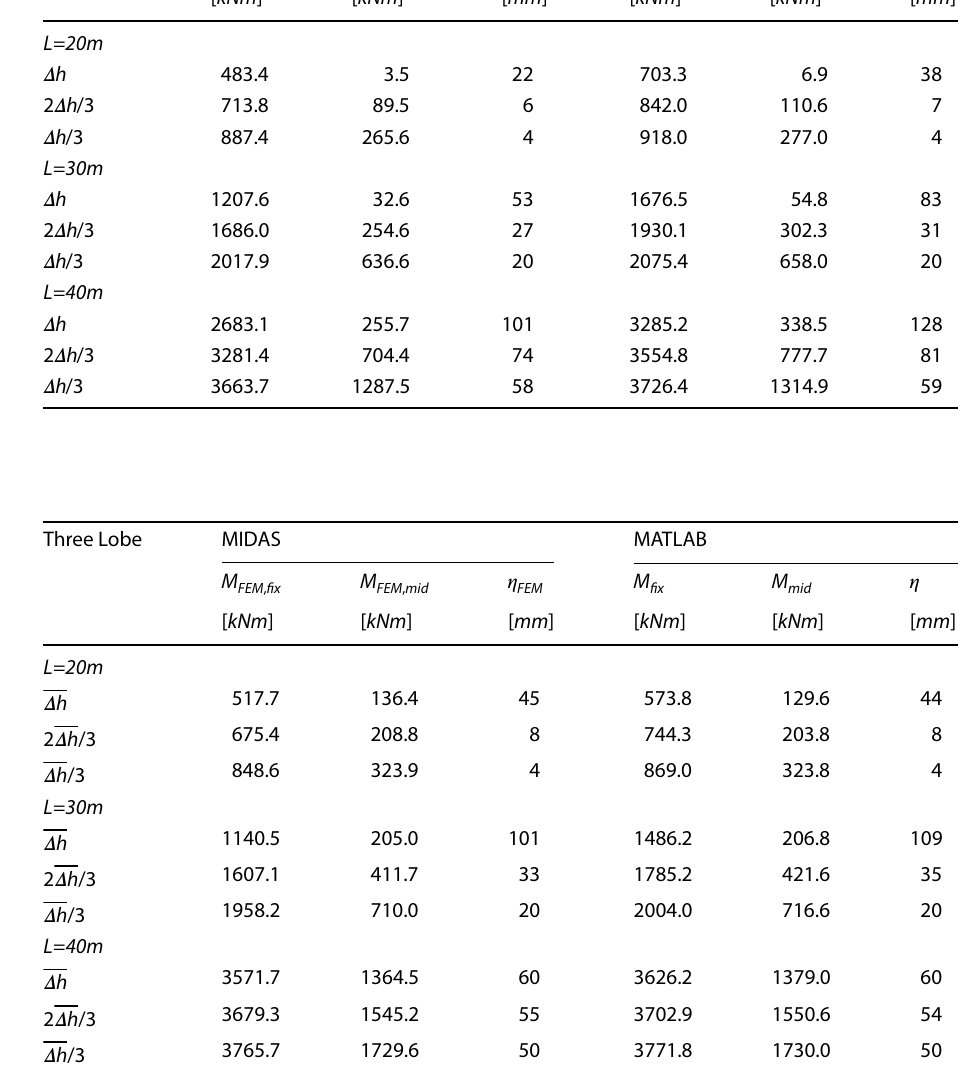
Table 2 Comparison of bending moments at fixed joint ( M fix ) and in midspan